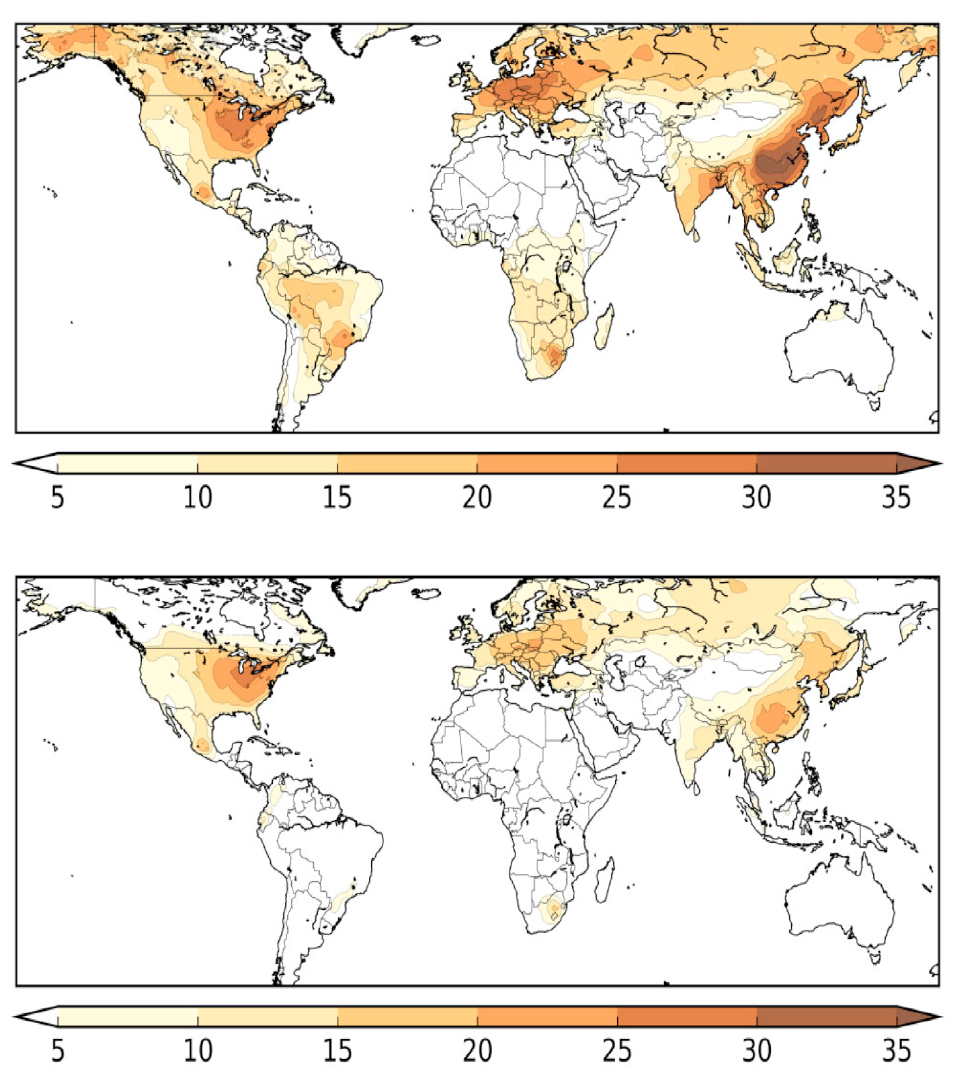
Figure 3. Estimated percentages of COVID-19 mortality attributed to air pollution from all anthropogenic sources ( top ), and from fossil fuel use only ( bottom ). The regions with high attributable fractions coincide with high levels of air pollution. The mapped results account for population density, thus reflecting population weighted exposure to PM2.5. Reproduced under licence N ◦ 5070720206174 from: Pozzer A., Dominici F., Haines A., Witt C., Münzel T., and Lelieveld J. Regional and global contributions of air pollution to risk of death from COVID-19. Cardiovascular Research (2020) 116, 2247–2253, doi:10.1093/cvr/cvaa288